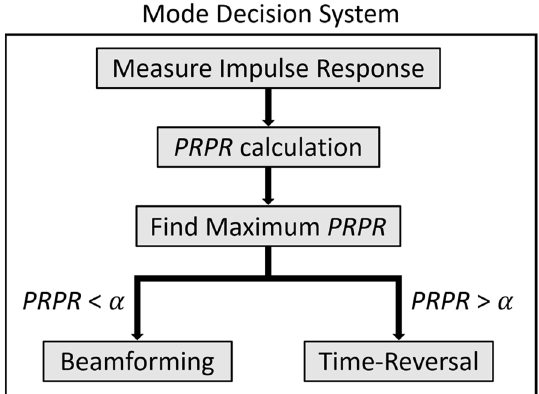
Figure 7. Flow chart of a notional mode decision